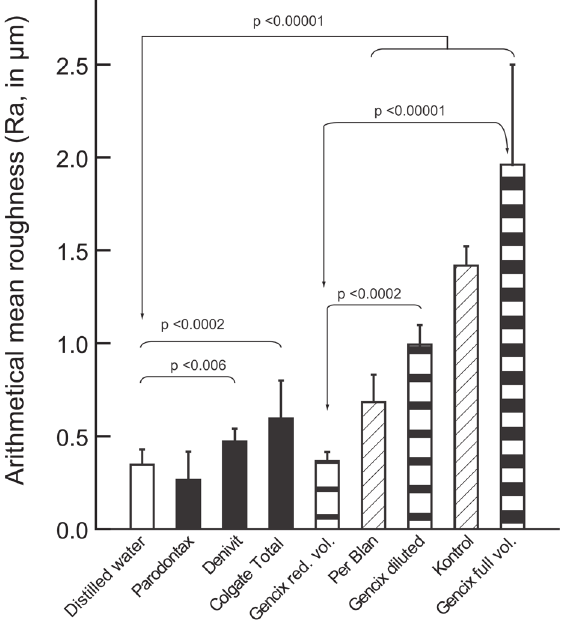
Figure 5- Surface roughness analysis after brushing with the different dentifrices. Bars correspond to the average value obtained on the 3 blocks analyzed per dentifrice (12 images per block). Data are expressed as mean±standard deviation. Toothbrushes used with distilled water: white bar; with toothpastes: black bars; with toothpowders: patterned bars. The different ways of using Gencix ® appear with different types of horizontal patterned